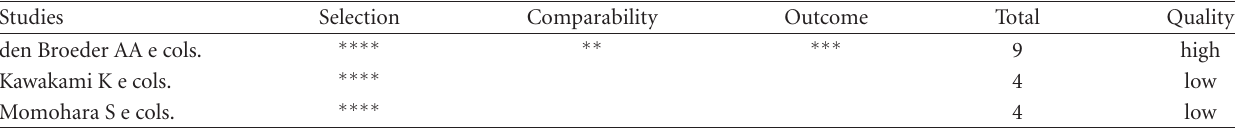
Table 2: Quality of studies according to Newcastle-Ottawa Cohort Quality Assessment Scale. Studies Selection